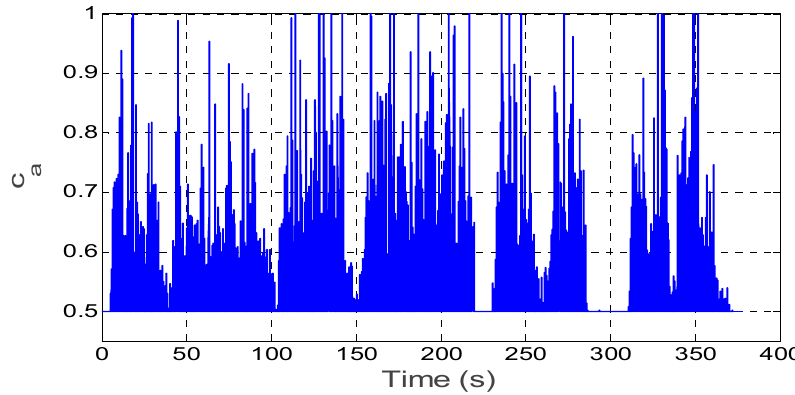
Figure 8. Adaptive switch for c a in the kinematic vehicle experiment.